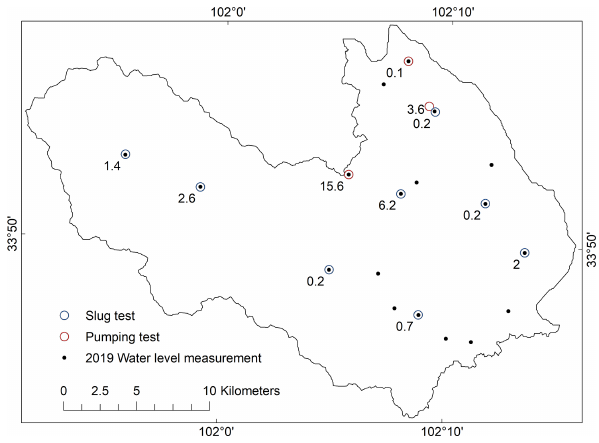
Figure 10. Hydraulic conductivity (md − 1 ) obtained from aquifer tests in the Maqu